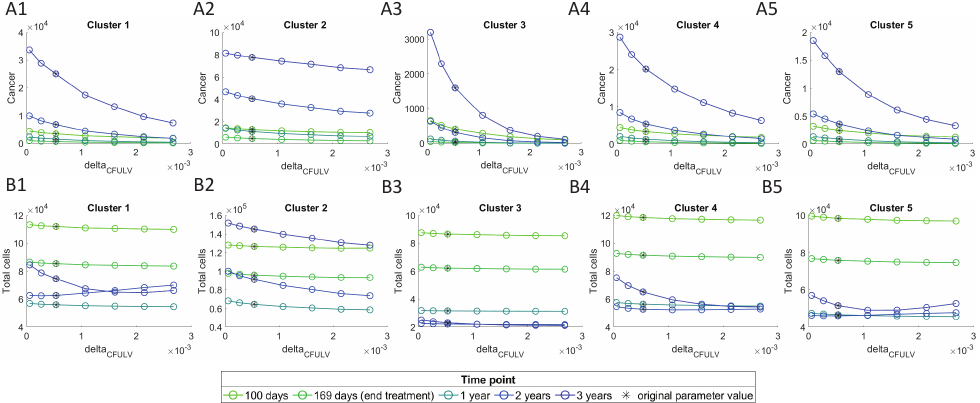
Figure 9. Cancer and total cells as a function of δ C 5 fuLV . ( A1 – A5 ) depict number of cancer cells and ( B1 – B5 ) depict number of total cells, at different time